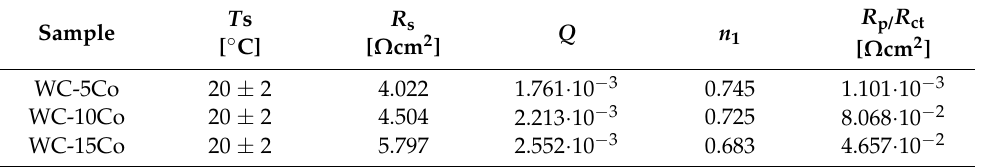
Table 4. Electrochemical impedance spectroscopy EIS technique